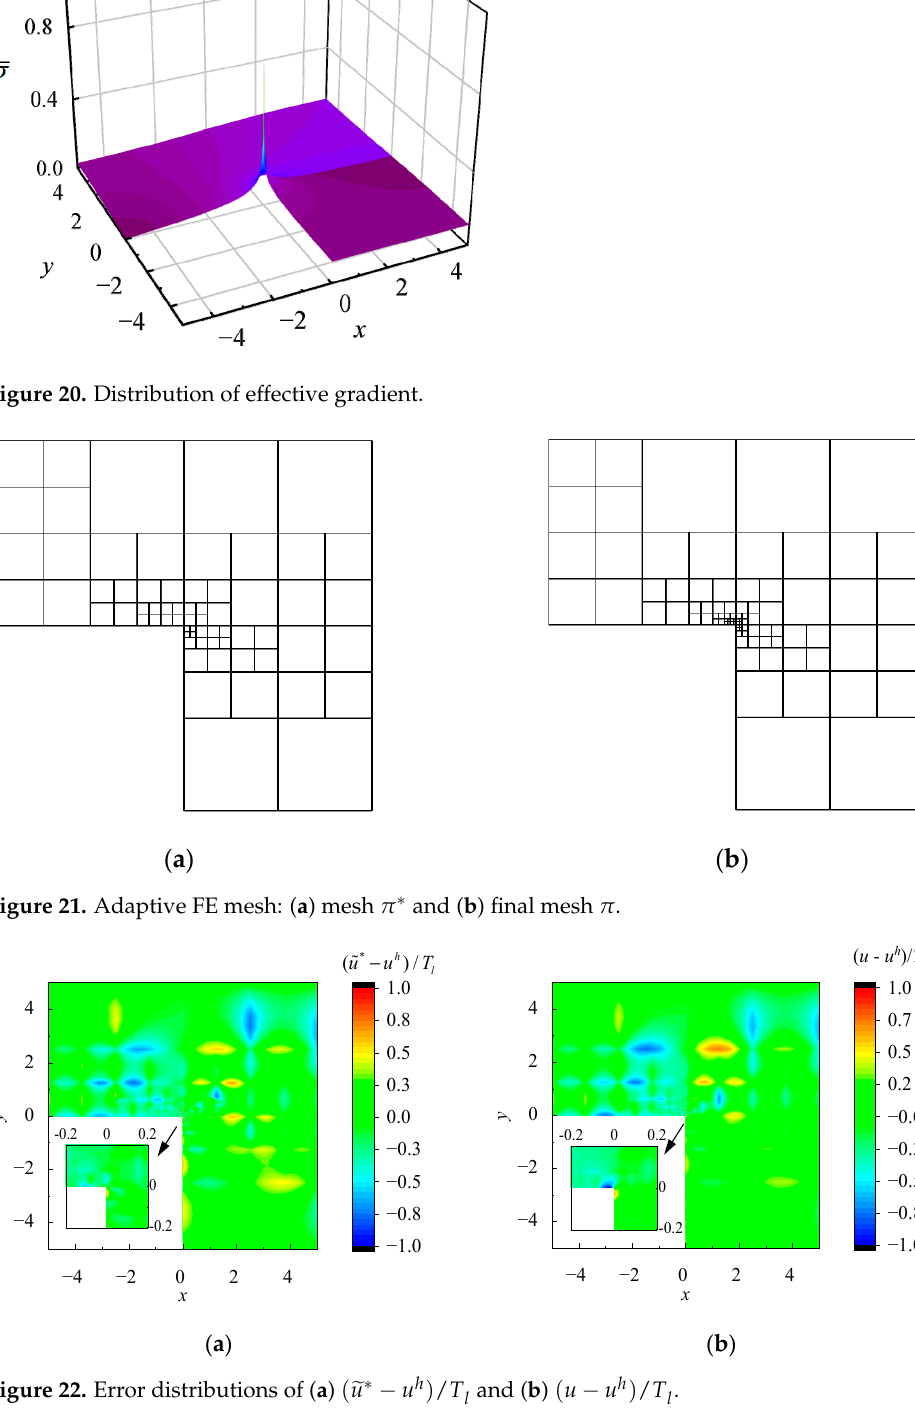
Figure 22. E rror distributions of ( a ) . Figure 22. Error distributions of ( a ) ( (cid:101) u ∗ − u h ) / T l and ( b ) ( u − u h ) / T l